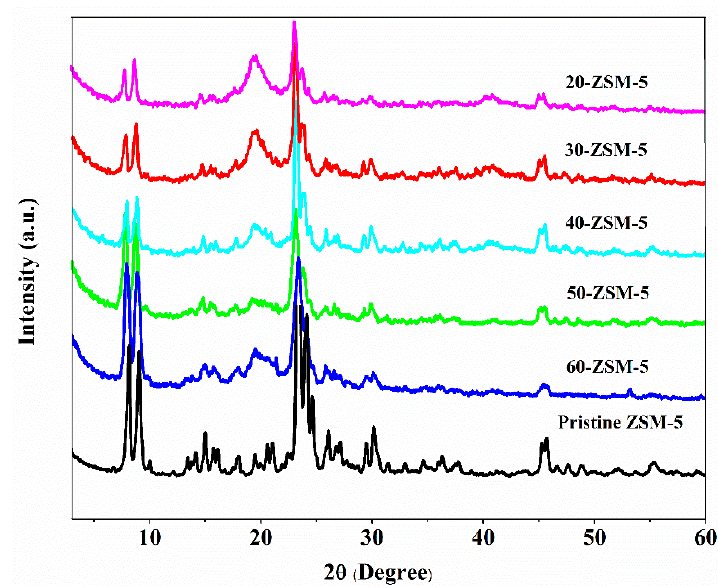
Figure 5. XRD pattern of ZSM-5 / PVA-based mixed matrix membranes (MMMs) in comparison with the ZSM-5 zeolite powder.